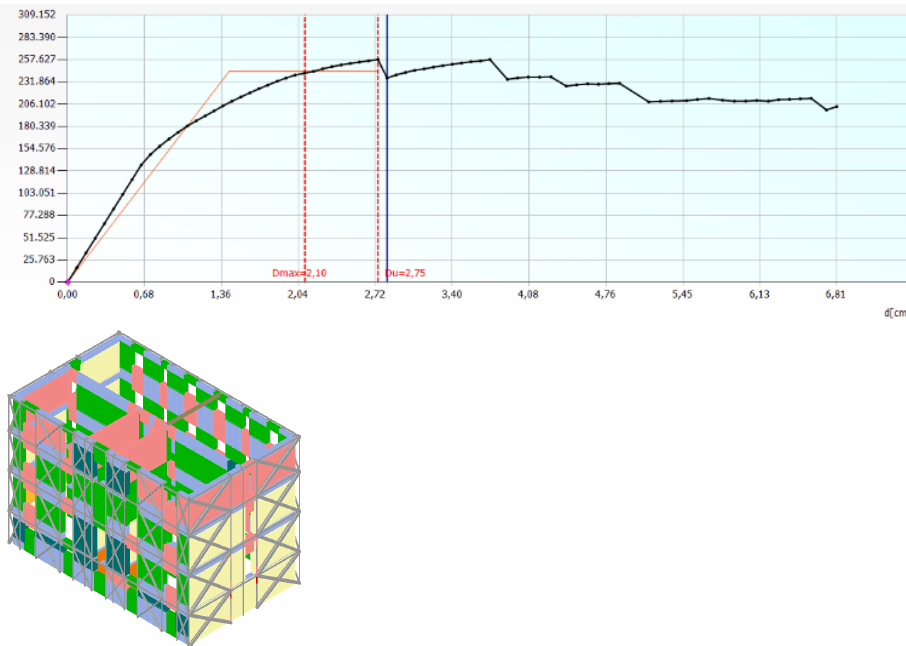
Figure 23. Results of analysis No. 11 in X-direction on the retrofitted building.